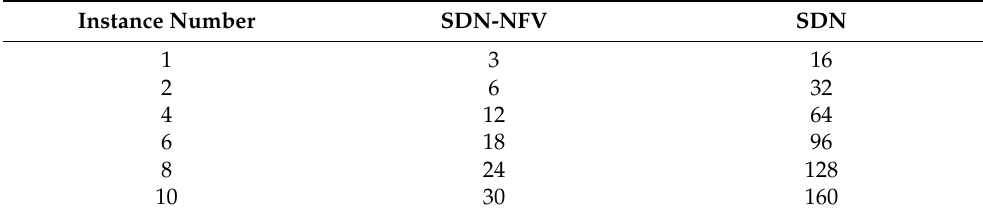
Table 9. VM controller integration measurement time